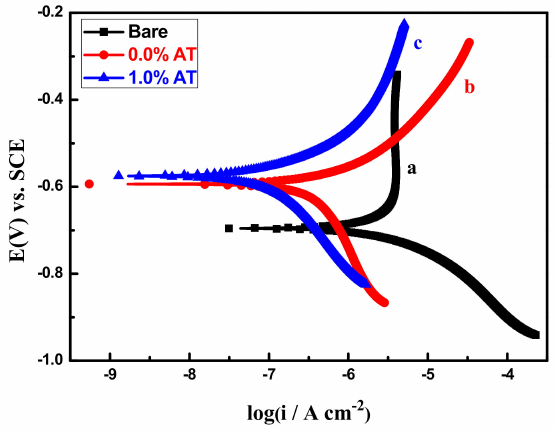
Figure 8. The polarization curves of bare ( a ), pure epoxy-coated ( b ), and epoxy coating with 1.0%AT-coated ( c ) Q235 steel electrodes after immersion in 3.5% NaCl for 24